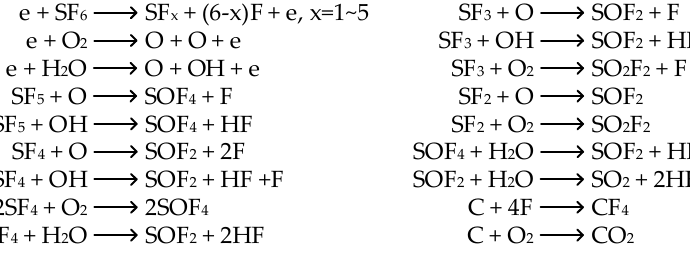
Figure 7. Formation process of SF 6 decomposed components.